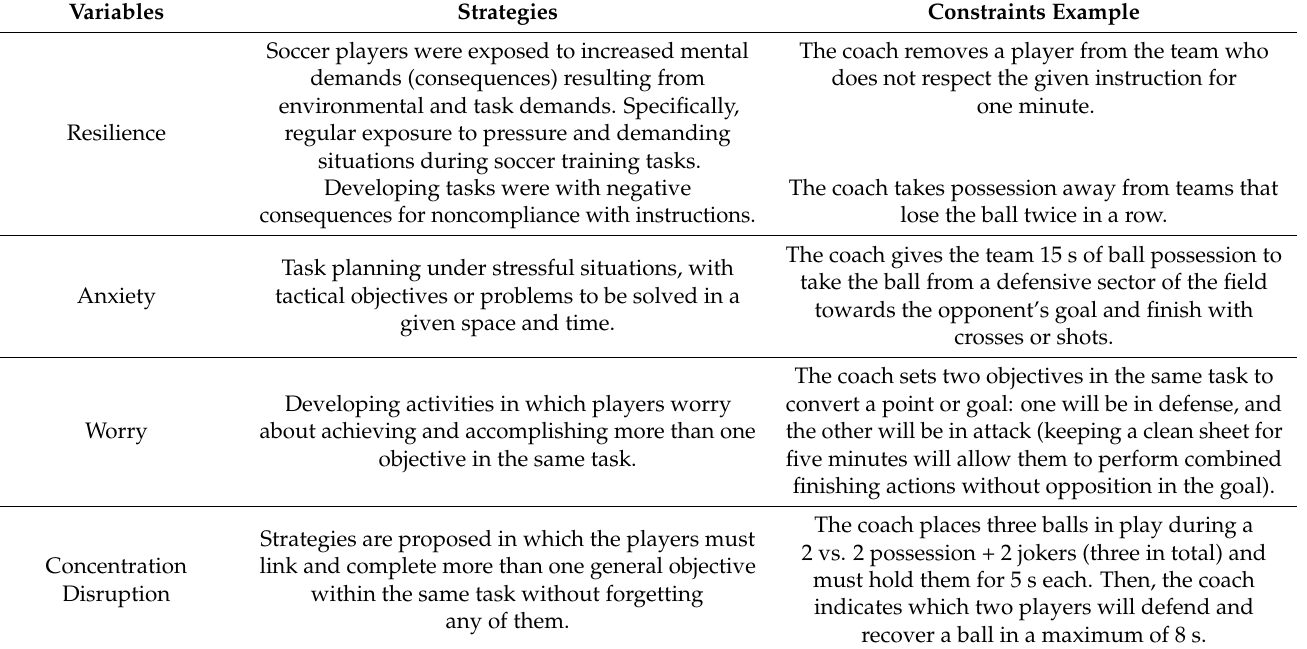
Table 2. Overview of the program